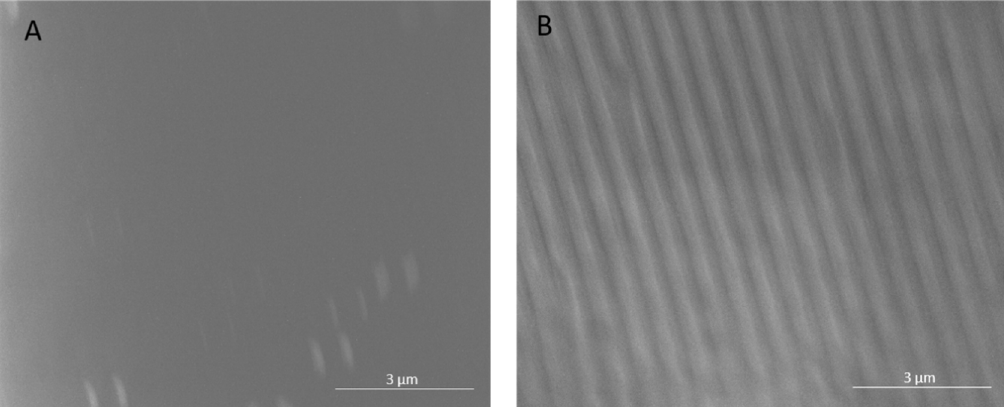
Figure 2. SEM images of a ( A ) pristine and ( B ) patterned NF270 membrane. Images were taken at 12,000× magnification and the common scale bar is 3 μ m.